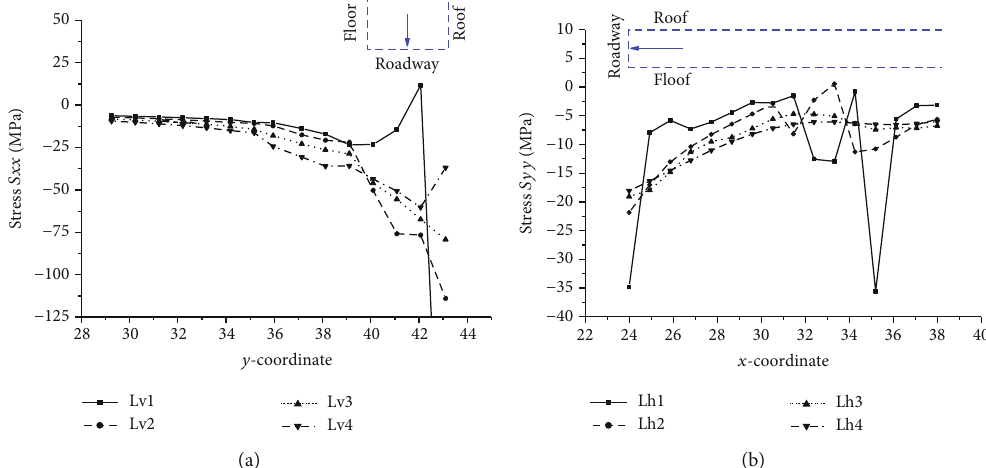
Figure 11: Comparison of the di ff erential stresses in the coal pillar and fl oor for cycle 14. (a) The vertical axis is the normal stress in the x direction on monitoring lines Lv1 ~ 4 in the coal pillar, and the horizontal axis is the distance in the y -coordinate direction. (b) The vertical axis is the normal stress in the y direction on monitoring lines Lh1 ~ 4 in the fl oor, and the horizontal axis is the distance in the x -coordinate